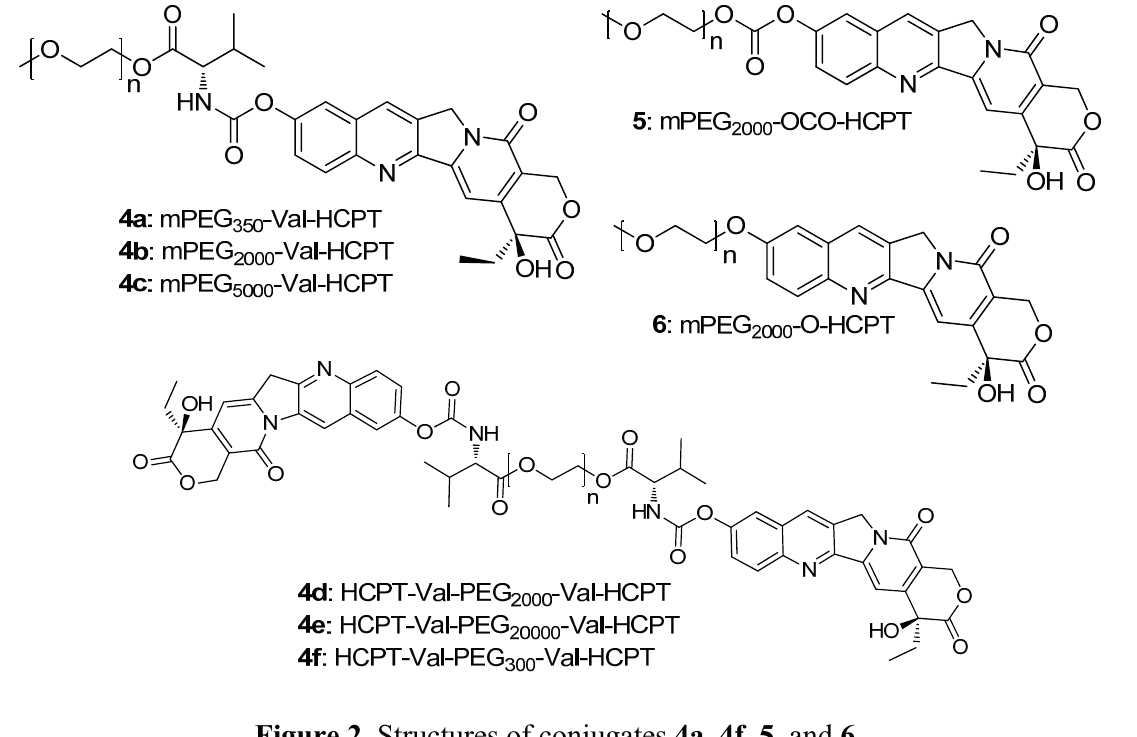
Figure 2. Structures of conjugates 4a – 4f , 5 , and 6